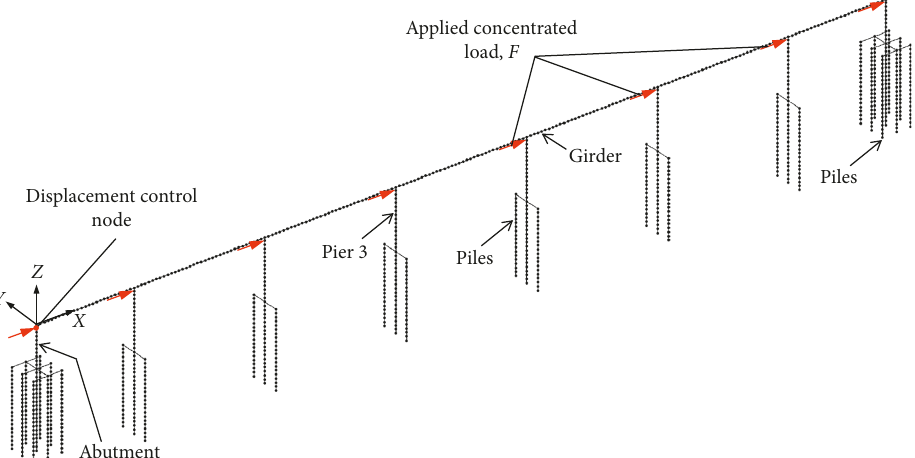
Figure 8: Fully integral bridge model load distribution.